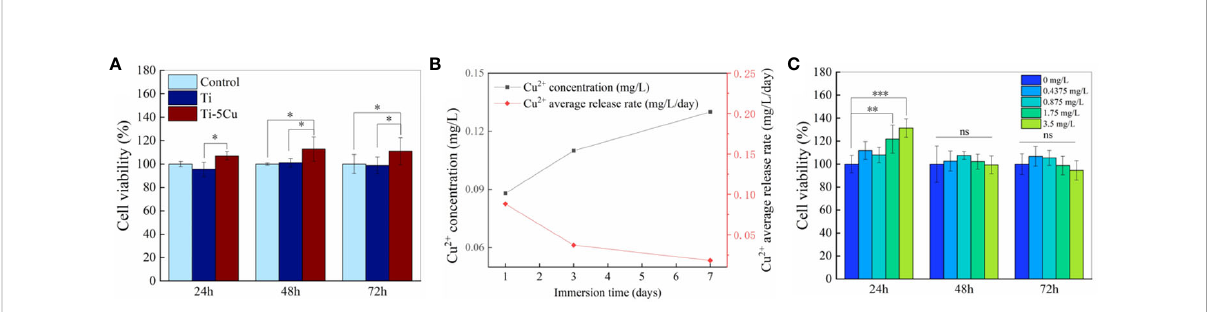
FIGURE 3 Cu 2+ release and cytotoxicity. (A) The cell viability of RAW264.7 after co-cultured with Ti and Ti-5Cu alloy at 24, 48, and 72 h, respectively. (B) Concentration and average release rate of Cu 2+ in Ti-5Cu alloy immersed in DMEM medium. (C) The cell viability of RAW264.7 cultured in different concentration of Cu 2+ culture medium at 24, 48, and 72 h , respectively (n = 4; *p < 0.05, **p < 0.01, and ***p < 0.001; ns, no signi fi cant difference).